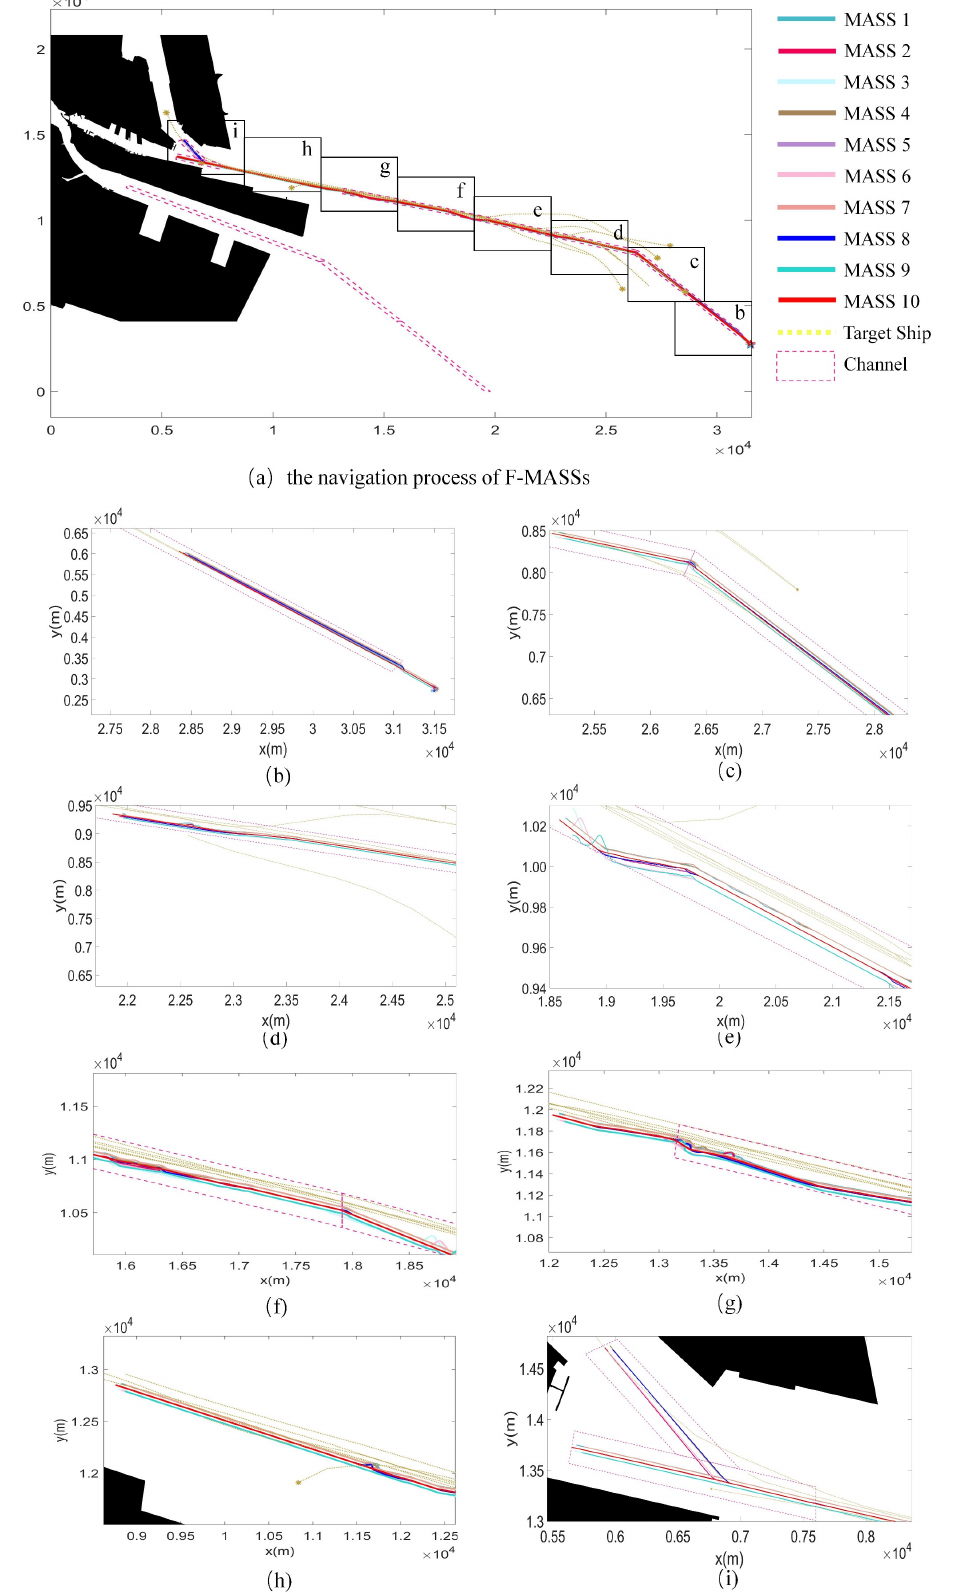
Figure 15. Time-specific marching diagram of formation, (a) is the navigation process of for- mation, (b)-(i) are the enlarged view of each